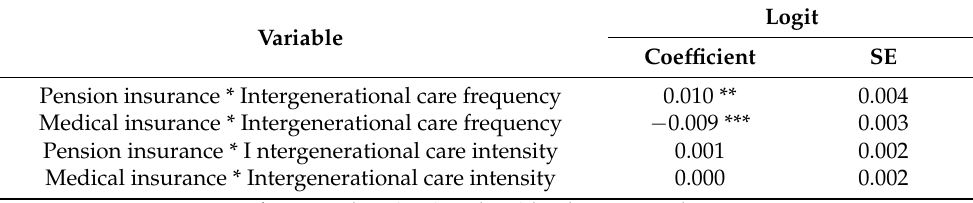
Table 7. The effect of interaction terms on elderly farmers’ cultivated land renting out